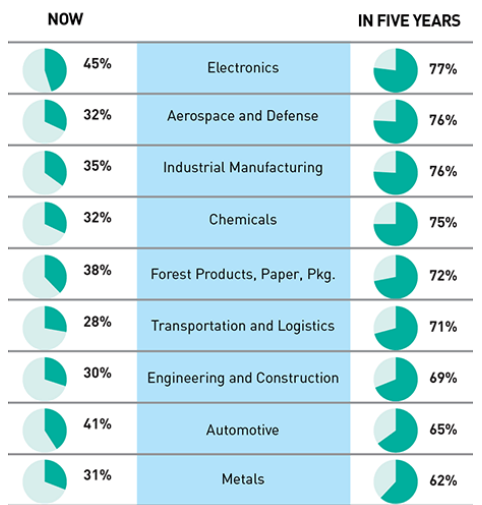
Figure 2. Adoption of Industry 4.0 by sector [68]